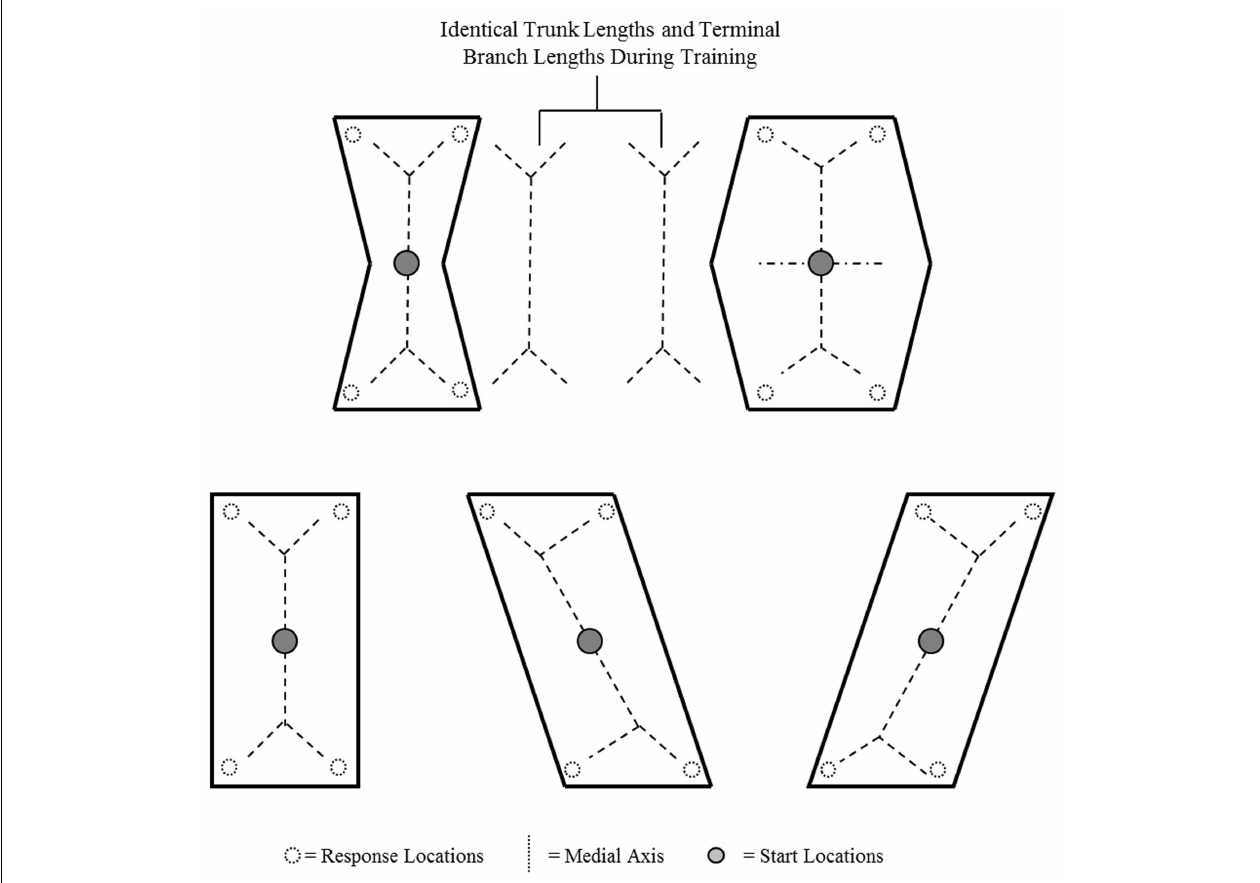
FIGURE 3 | Schematics of training and testing enclosures of Sturz and Bodily (2011a) with the medial axis for each enclosure. Unfilled circles represent invisible response locations, and filled circles represent start